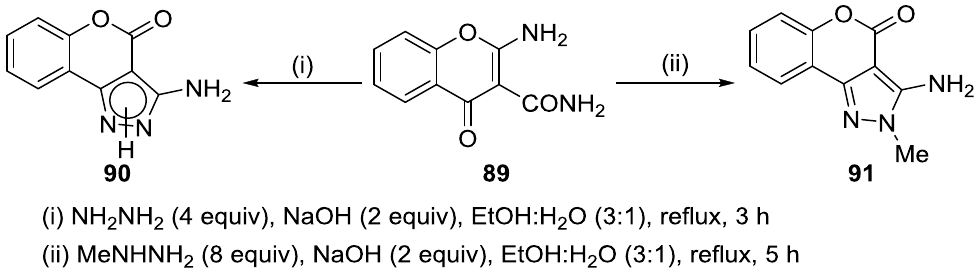
The reaction of 2-amino-3-carbamoylchromone 89 with hydrazines afforded